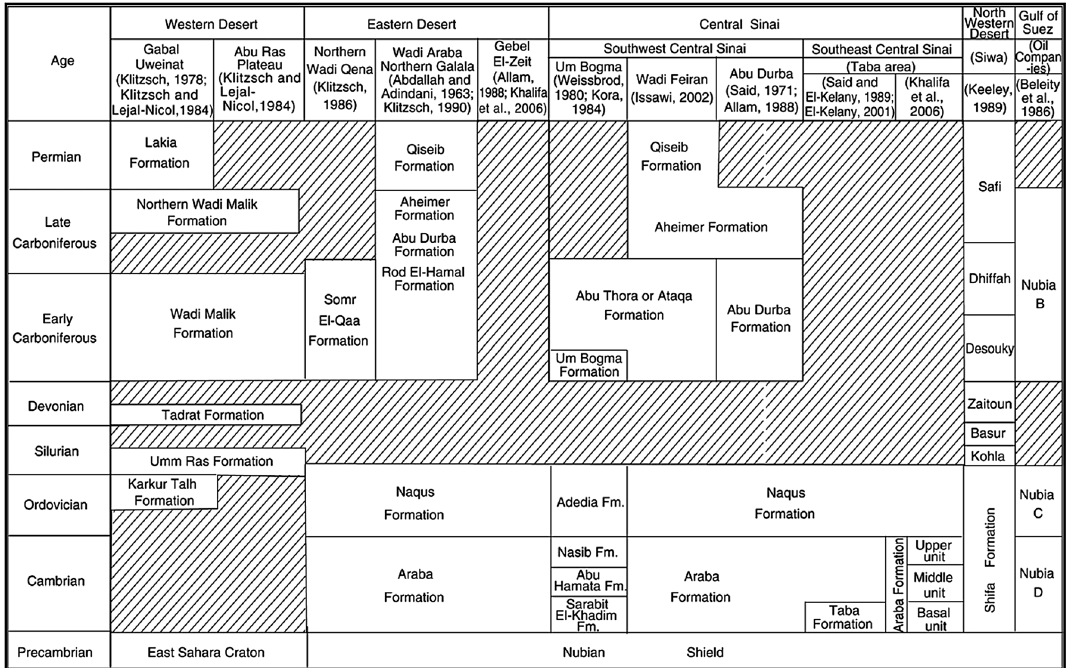
Table 1 Correlation chart of the Paleozoic rock units in Egypt (modified after